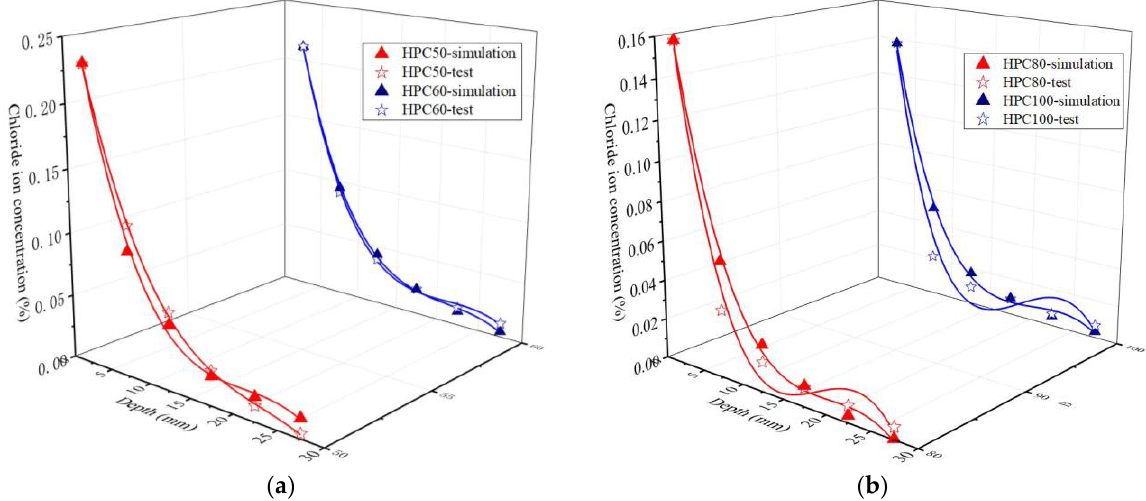
Figure 13. Chloride ion concentration of test and microscopic simulation at different depth: ( a ) HPC50 and HPC60; ( b ) HPC80 and HPC100.